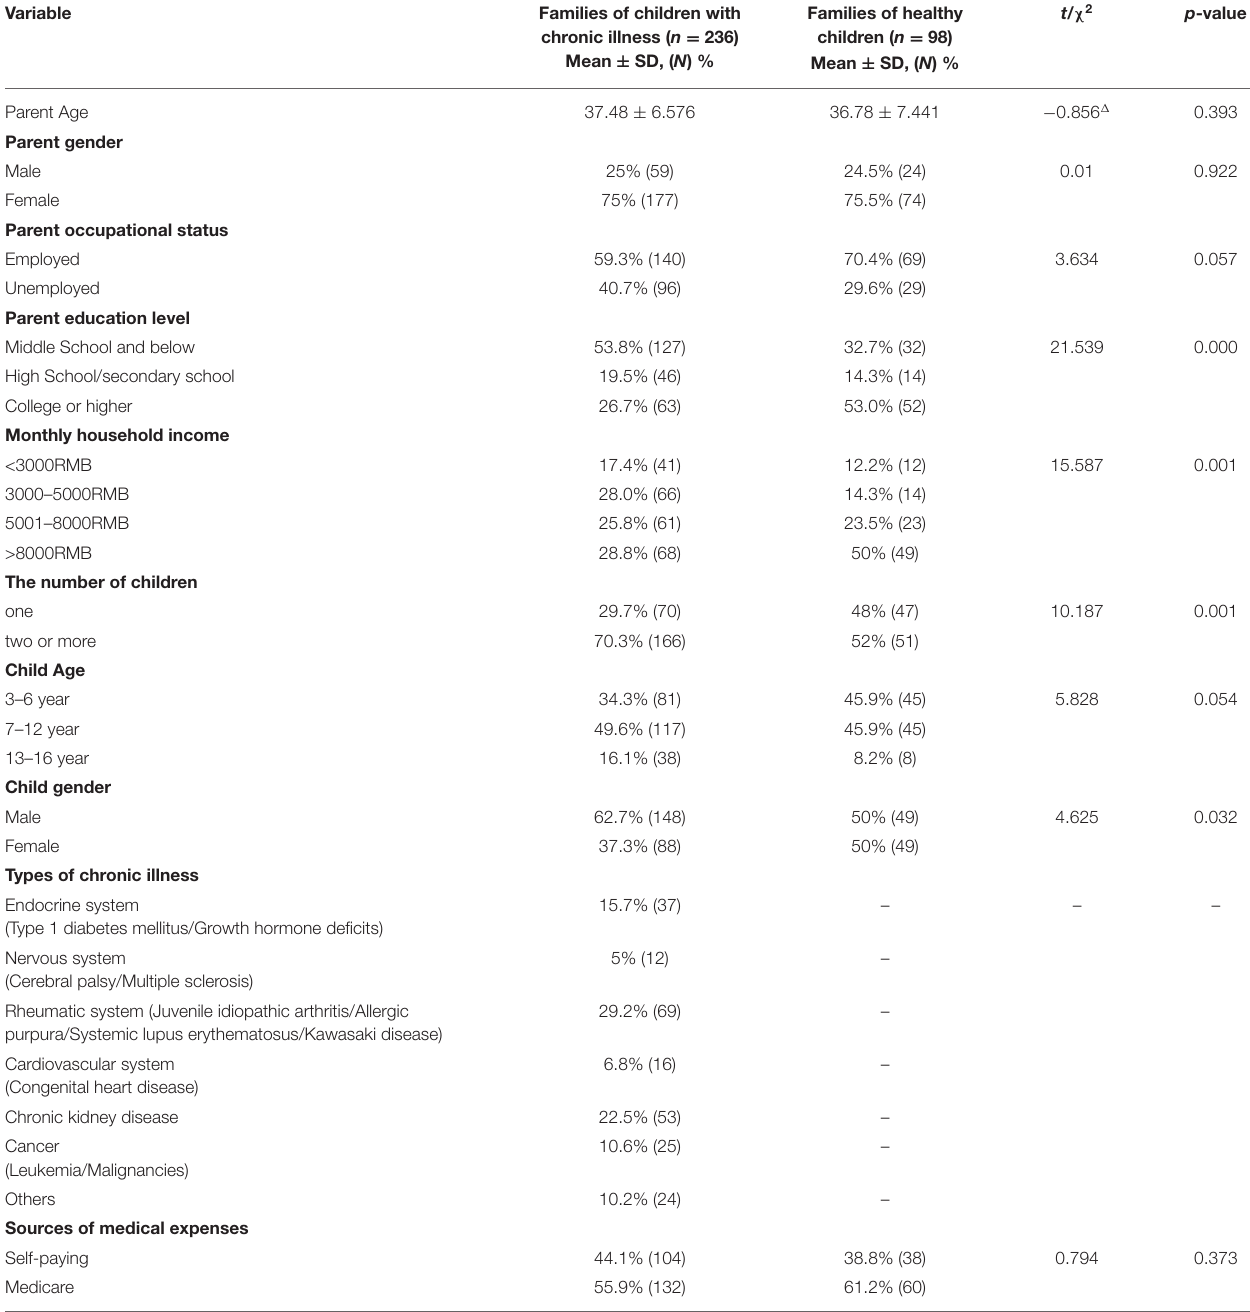
TABLE 1 | Demographic characteristic of families of children with chronic illness and families of healthy children.